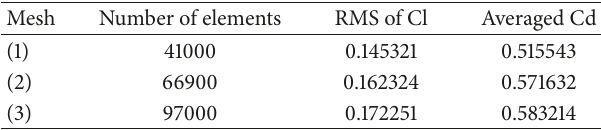
Table 2: Mesh convergence results.